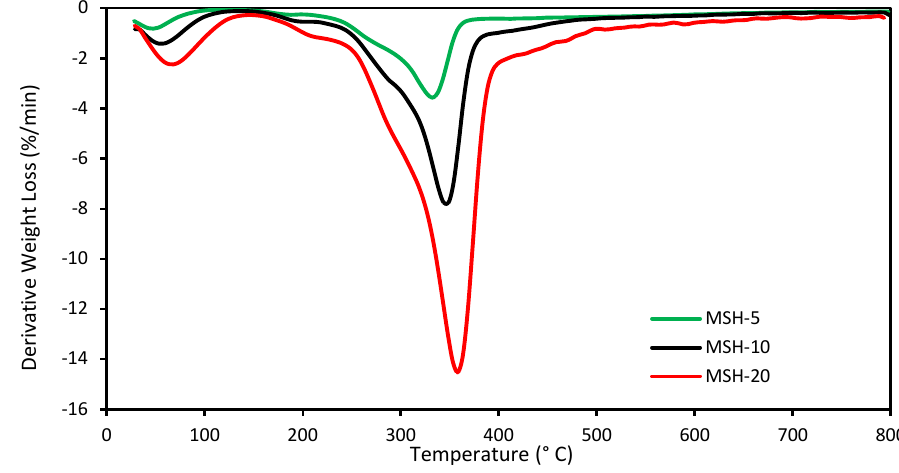
Fig. 3. DTG Curves for MSH at 5, 10 and 20 °C min −1